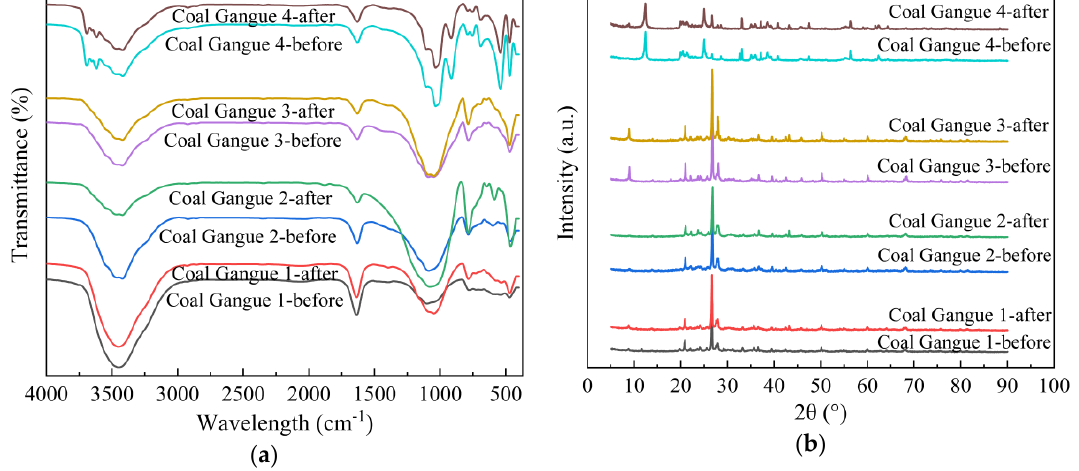
Figure 11. Fourier transform infrared spectroscopy (FTIR) and X-ray diffraction (XRD) images of Coal Gangue 1–4 before and after AMD repaired by dynamic experiment. ( a ) FTIR image; ( b ) XRD image.